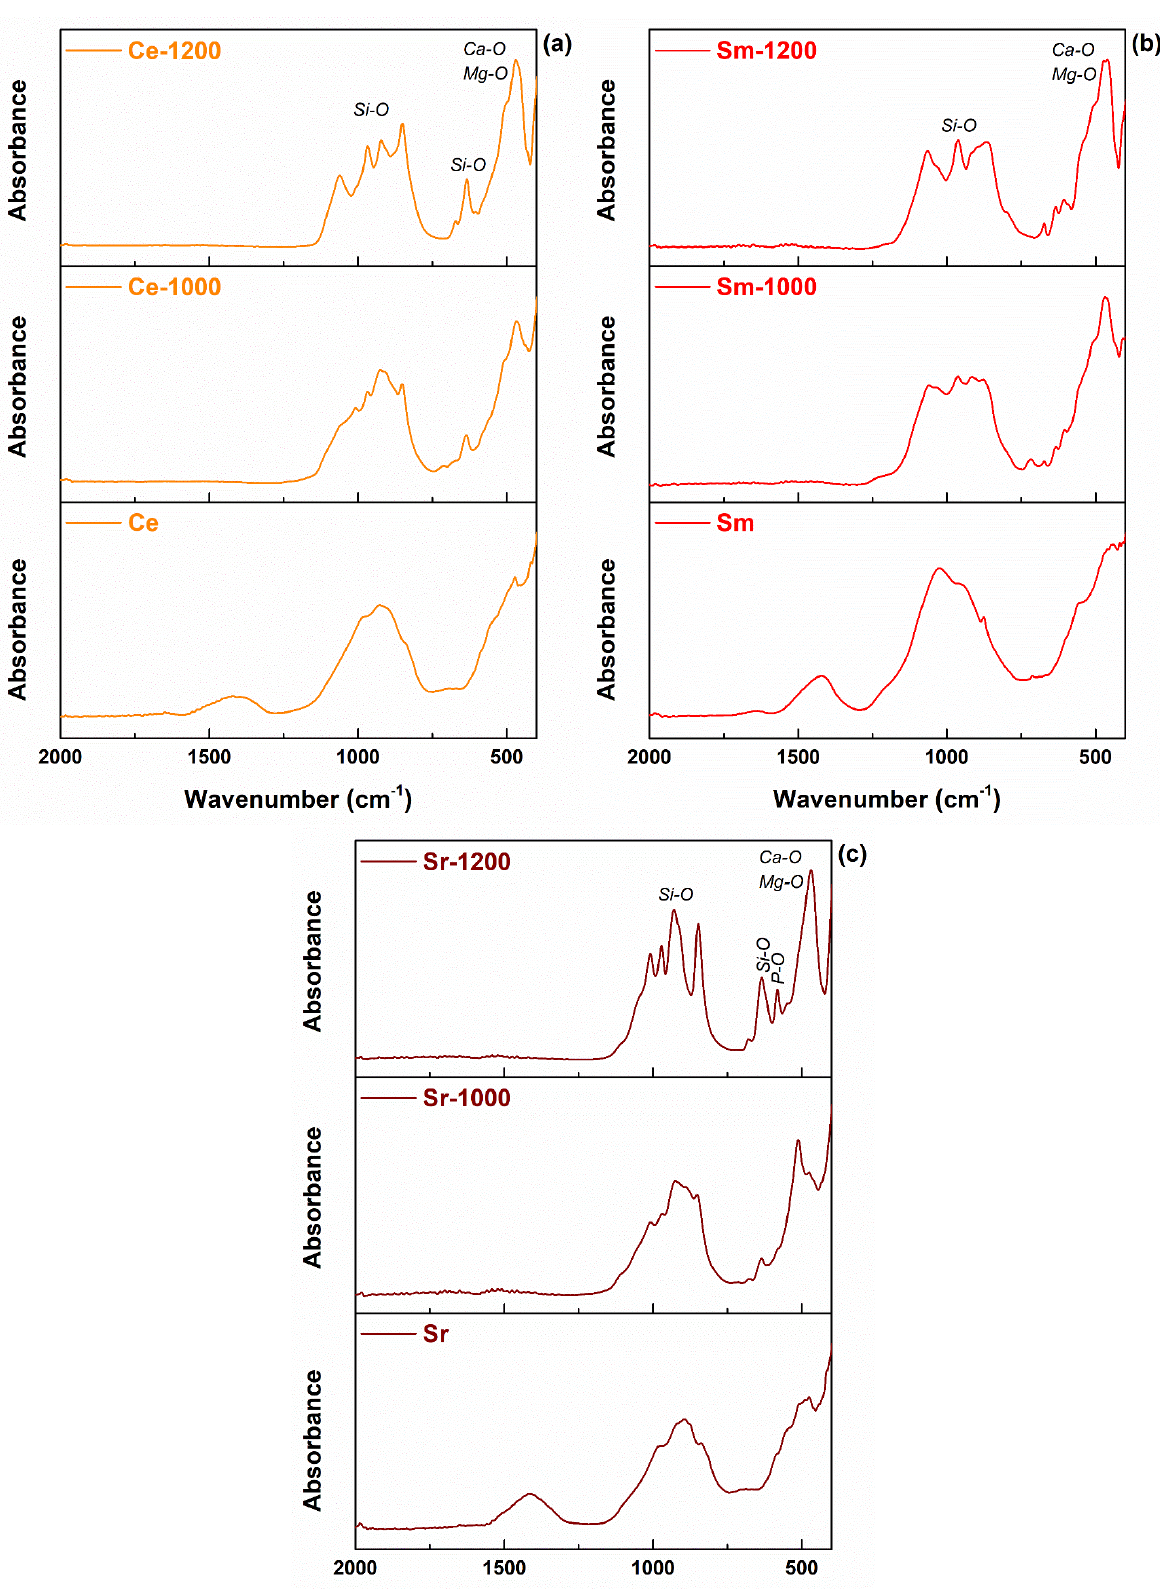
Figure 6. FTIR spectra of the developed materials: ( a ) Ce-containing composition, ( b ) Sm-containing composition and ( c ) Sr-containing composition.